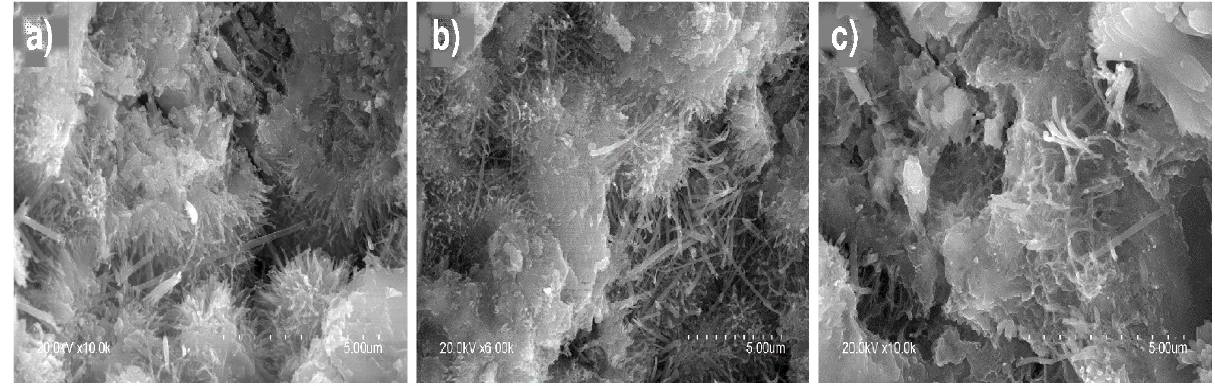
Figure 8. Calcium silicate hydrates (C-S-H gels) in 56-d water-soaked pastes: ( a ) OPC (×6000); ( b ) M1 (×6000); ( c ) M2 (×10,000).